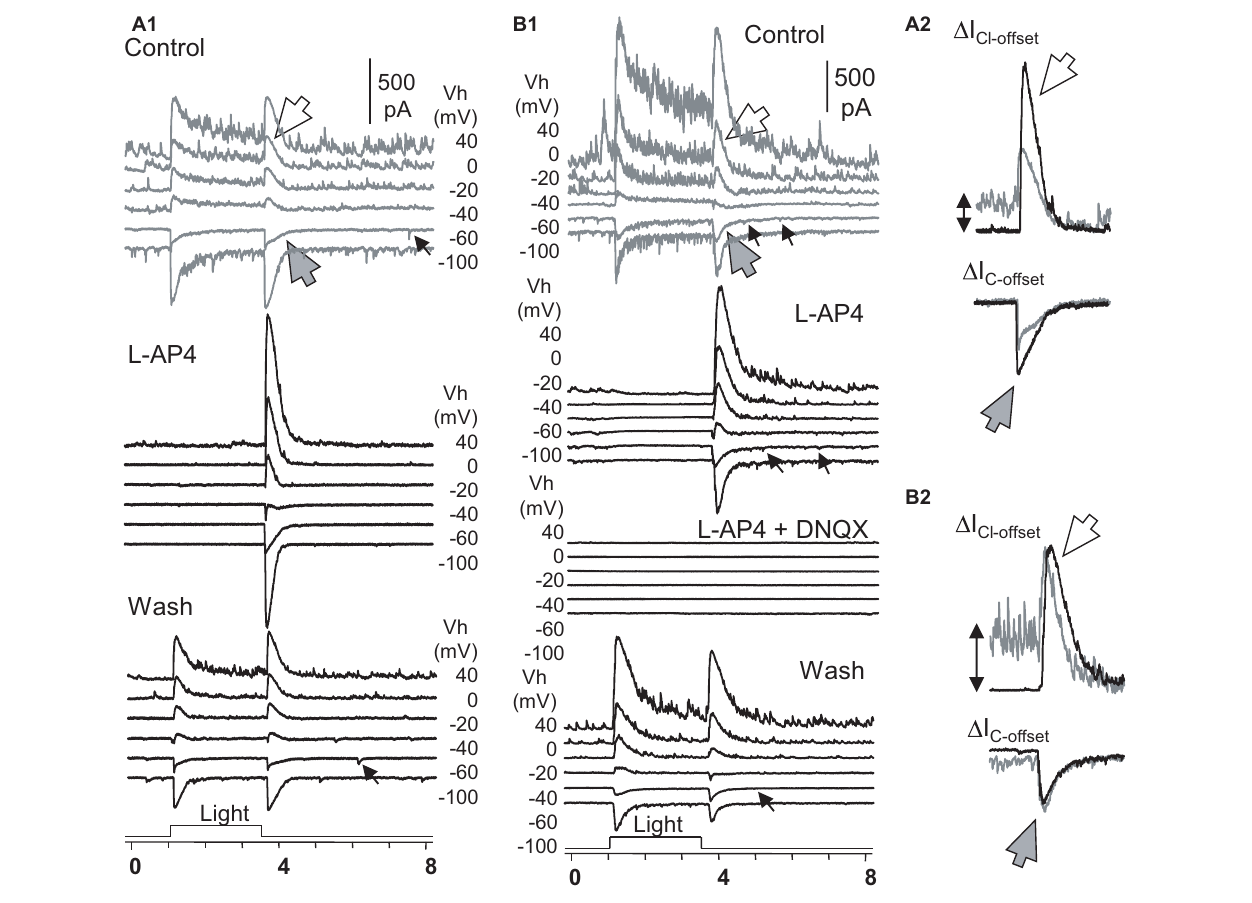
FIGURE 6 | The role of ON and OFF pathways in the OFF response of RGCs. (A,B) Under Voltage-clamp conditions, ON-OFF RGCs were recorded for light-evoked currents at a series of holding potentials (Vh). L-AP fully reversibly blocked the light-onset-evoked transient and sustained currents (A,B) but did not affect or even enhanced the chloride ( (cid:49) I Cl − offset , large white arrow) and cation ( (cid:49) I C − offset , large gray arrow) currents at light offset (A 2 ,B 2 ) . In L-AP4, sustained currents during light ON are neglectable, indicating that they are primarily mediated by DBCs. (A 2 ,B 2 ) The L-AP4-induced increase of (cid:49) I Cl − offset cannot be fully accounted for by the loss of the sustained (cid:49) I C component during the light ON. The minor (cid:49) I C − offset s (small arrow) that resemble the rod-driven component are blocked in A 2 but not in B 2 . All L-AP4-resistant activities are fully reversibly blocked by DNQX (B) . The results, combined with data in Figure 5 , indicate that RGC OFF responses are primarily mediated by DNQX-sensitive synapses, and the ON pathway could preferentially suppress inputs of OFF amacrine cells to RGCs, enhancing excitatory OFF response in RGCs. RGC, retinal ganglion cell; HBC, hyperpolarizing bipolar cell; DBC, depolarizing bipolar cell. The intensity of unattenuated [0 in log unit (log I)] 500 nm light from a halogen light source was 4.4 × 10 5 photons. µ m − 2 .s − 1 .